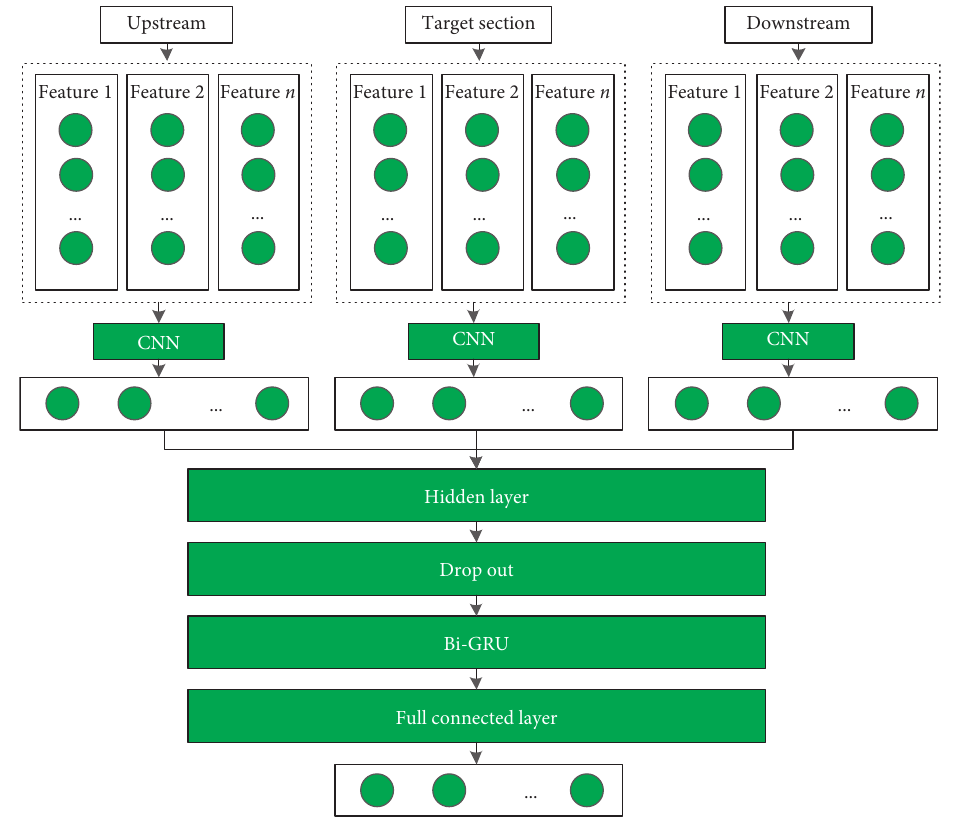
Figure 1: The proposed M-BiCNNGRU model structure. Table 1: The classification of truck type and the Passenger Car Equivalent (PCE) conversion